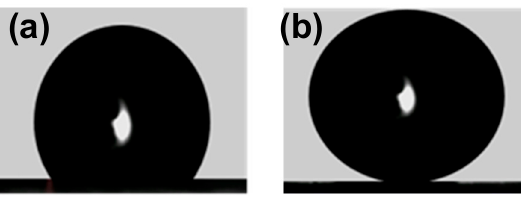
Figure 4. Water droplet contact angle on various surfaces after treatment with stearic acid: ( a ) smooth copper mesh surface prior to etching, ( b ) 60-min etching.